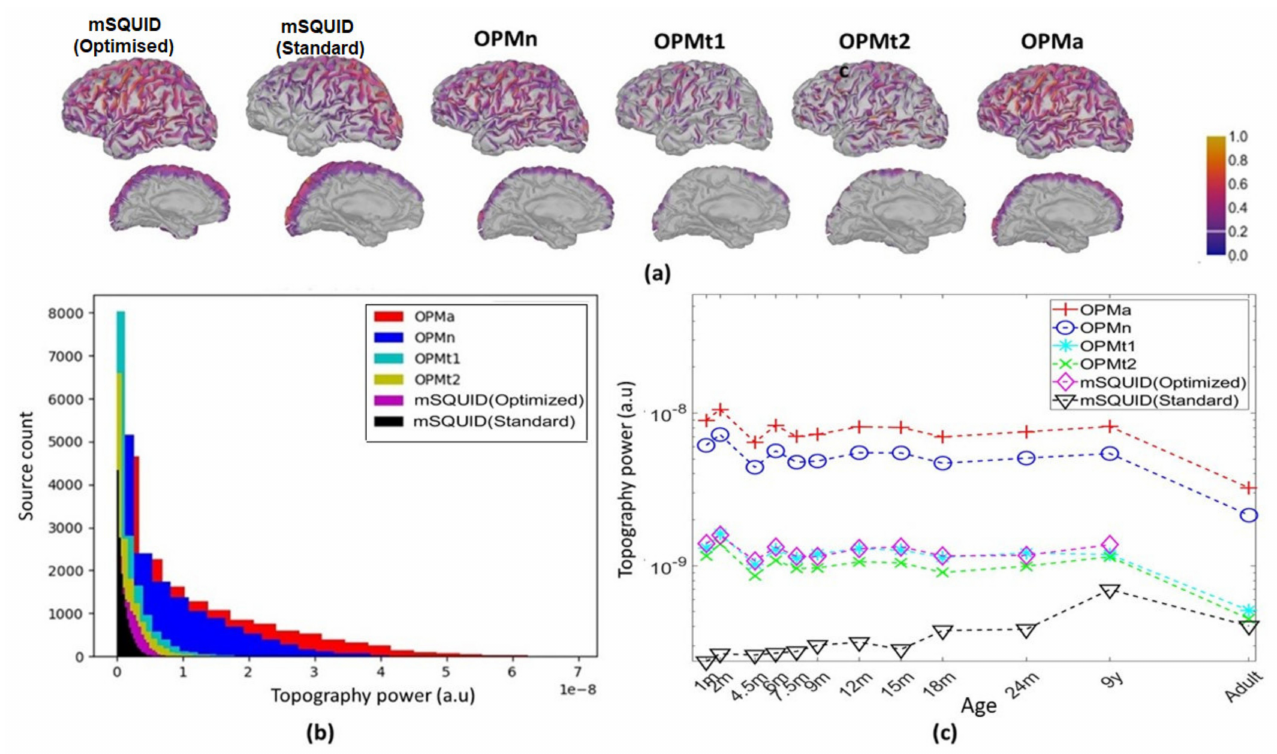
Figure 4. ( a ) Topographic powers of the arrays (for the nine-year-old subject). ( b ) Histograms of the distribution of the topographic power for sources in both hemispheres, for the same subject. ( c ) The topographic powers for various configurations of the sensor arrays, by subject age.